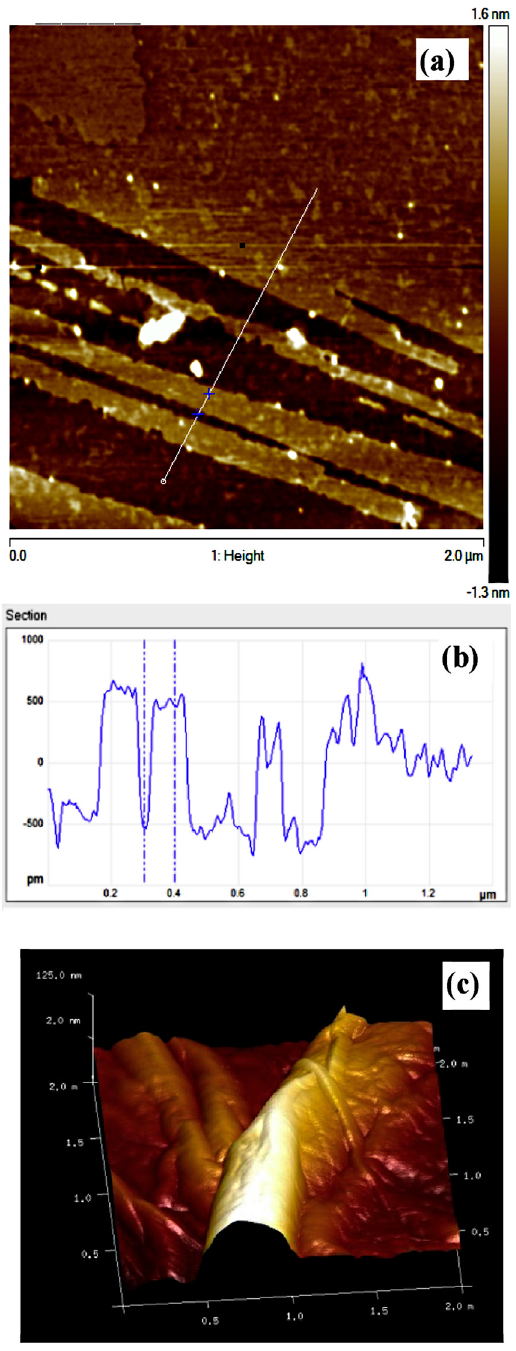
Figure 4. AFM images of the as prepared graphene oxide (GO) sample. ( a ) top view; ( b ) height profile of the region marked by the white line through the crosses in panel ( a ); ( c ) 3D view evidencing the wrinkling size. Reprinted from [118] with permission from Elsevier.